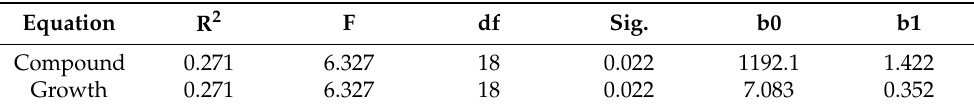
Table 1. Parameter of relationship between leaf litter amount and canopy width for a tree (variables in the